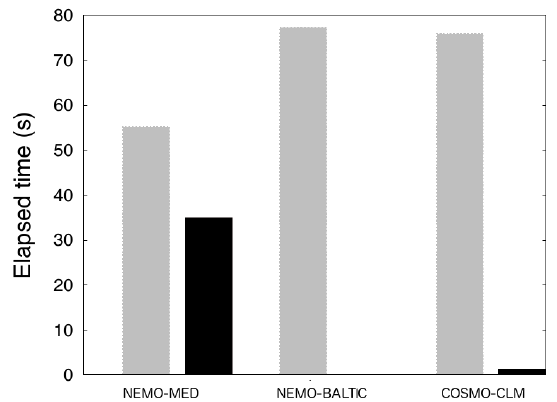
Figure 2. Computing time used for the exchange of each of the OA- SIS coupled model components. Grey bars show calculation time and black bars show waiting